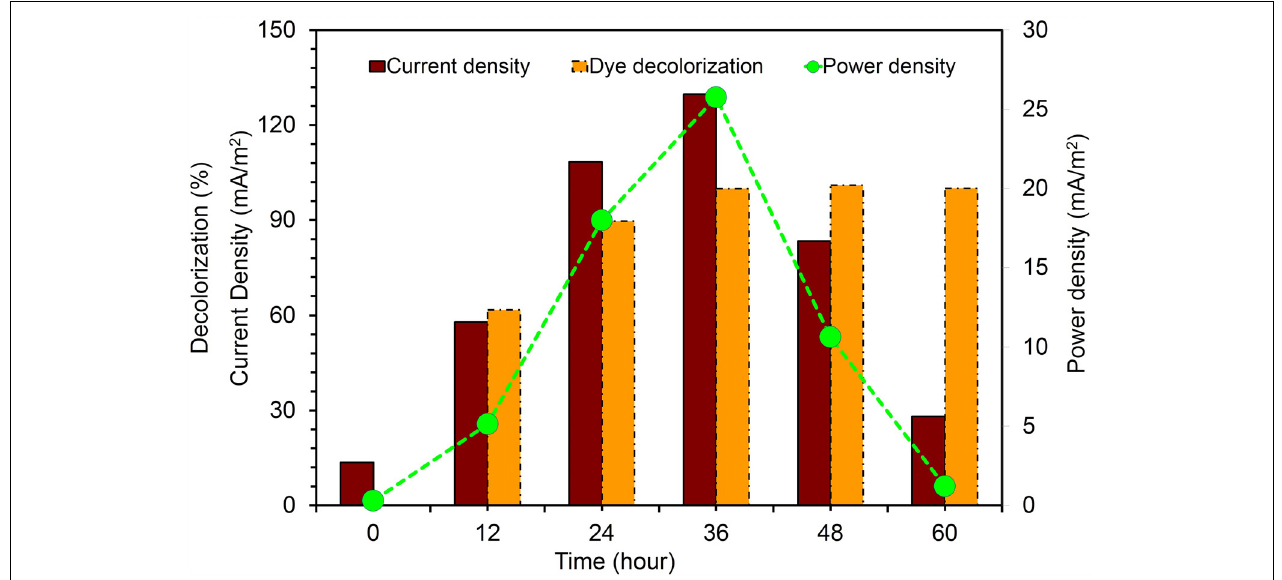
FIGURE 11 | Current generation and dye detoxification by Citrobacter sp. KVM11 in azo dye fed MERS Brown bar represents the current density produced from RB5 (400 mg/l) decolorization. Yellow bar represents the percent of RB5 removal in dye fed (400 mg/l) MFCs. Green closed circles represent the power density generation fron RB5 (400 mg/l) fed